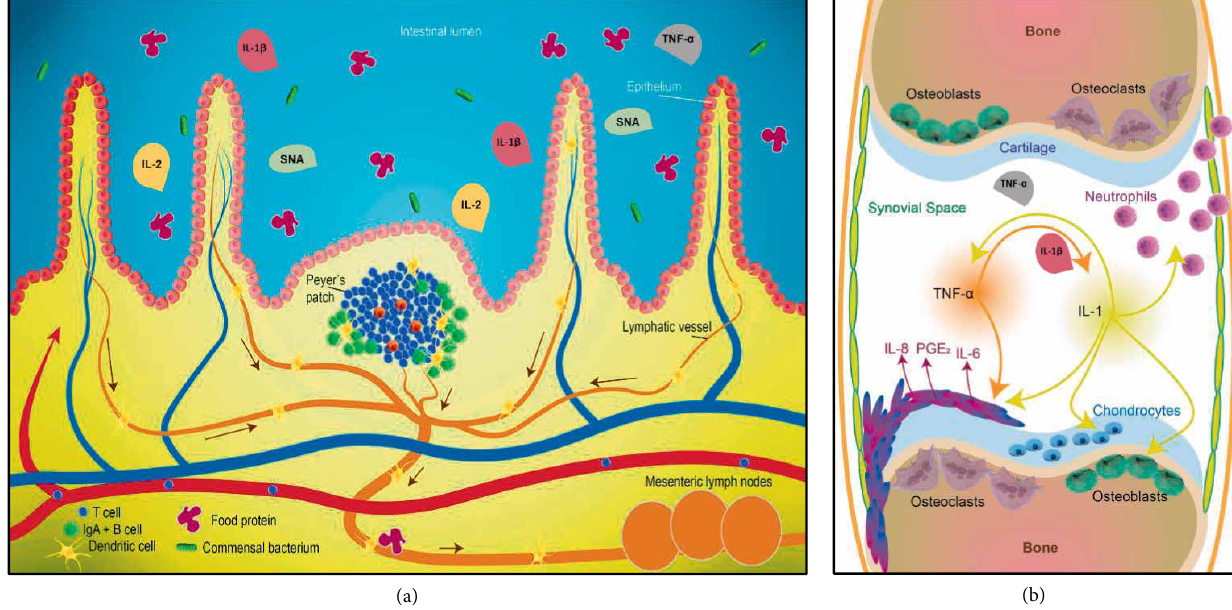
Figure 6: Mode of action of tested MIM. (a) Oral administered MIM can interact with cells of the innate and adaptive immune system present in the gut, reducing systemic inflammation and in turn, local inflammation of the synovial compartment. (b) RA is characterized by the presence of cytokines in the synovial compartment, fibroblasts assume an aggressive inflammatory phenotype, and chondrocytes enhance their catabolism promoting articular destruction. The tested MIM aimed at reducing levels of proinflammatory cytokines involved in pain and clinical signs of